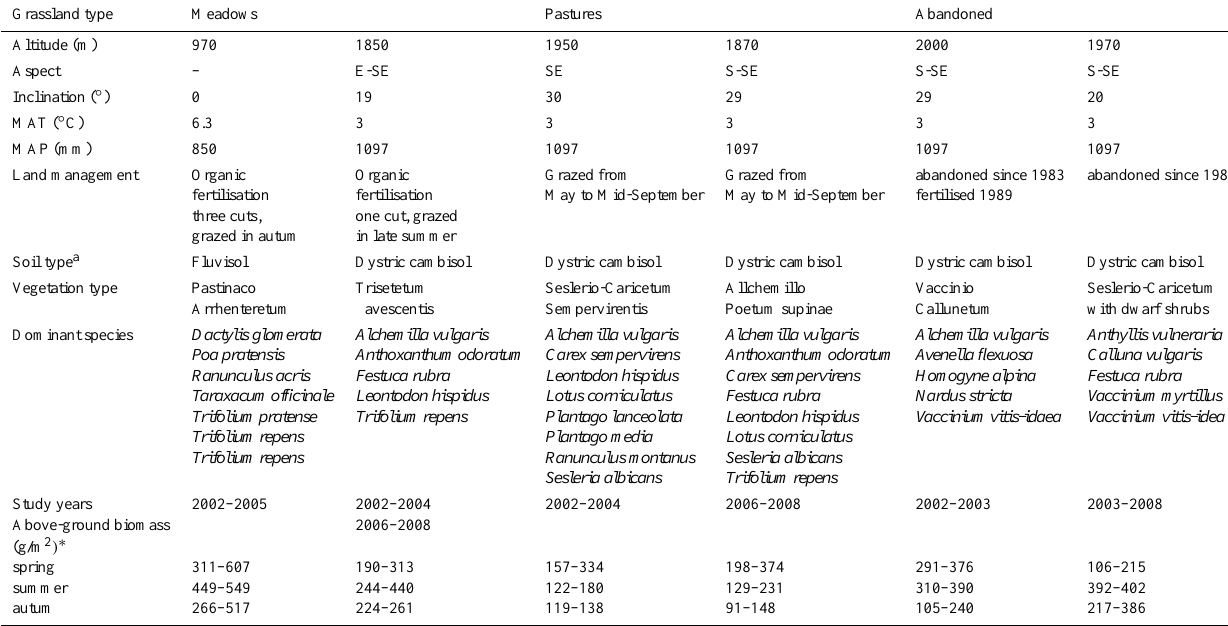
Table 1. General characterisation of the study sites. Grassland